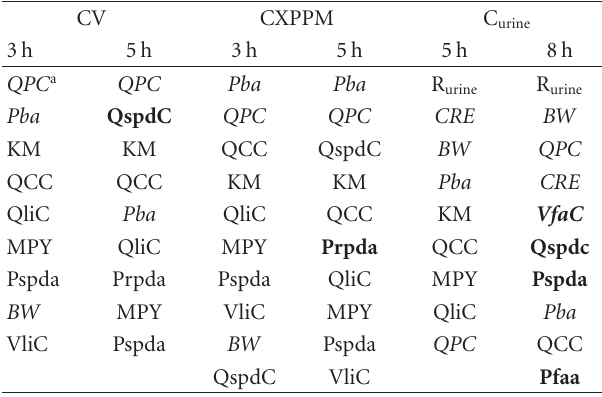
a Italicised abbreviations correspond to parameters measured for each volunteer listed in Table